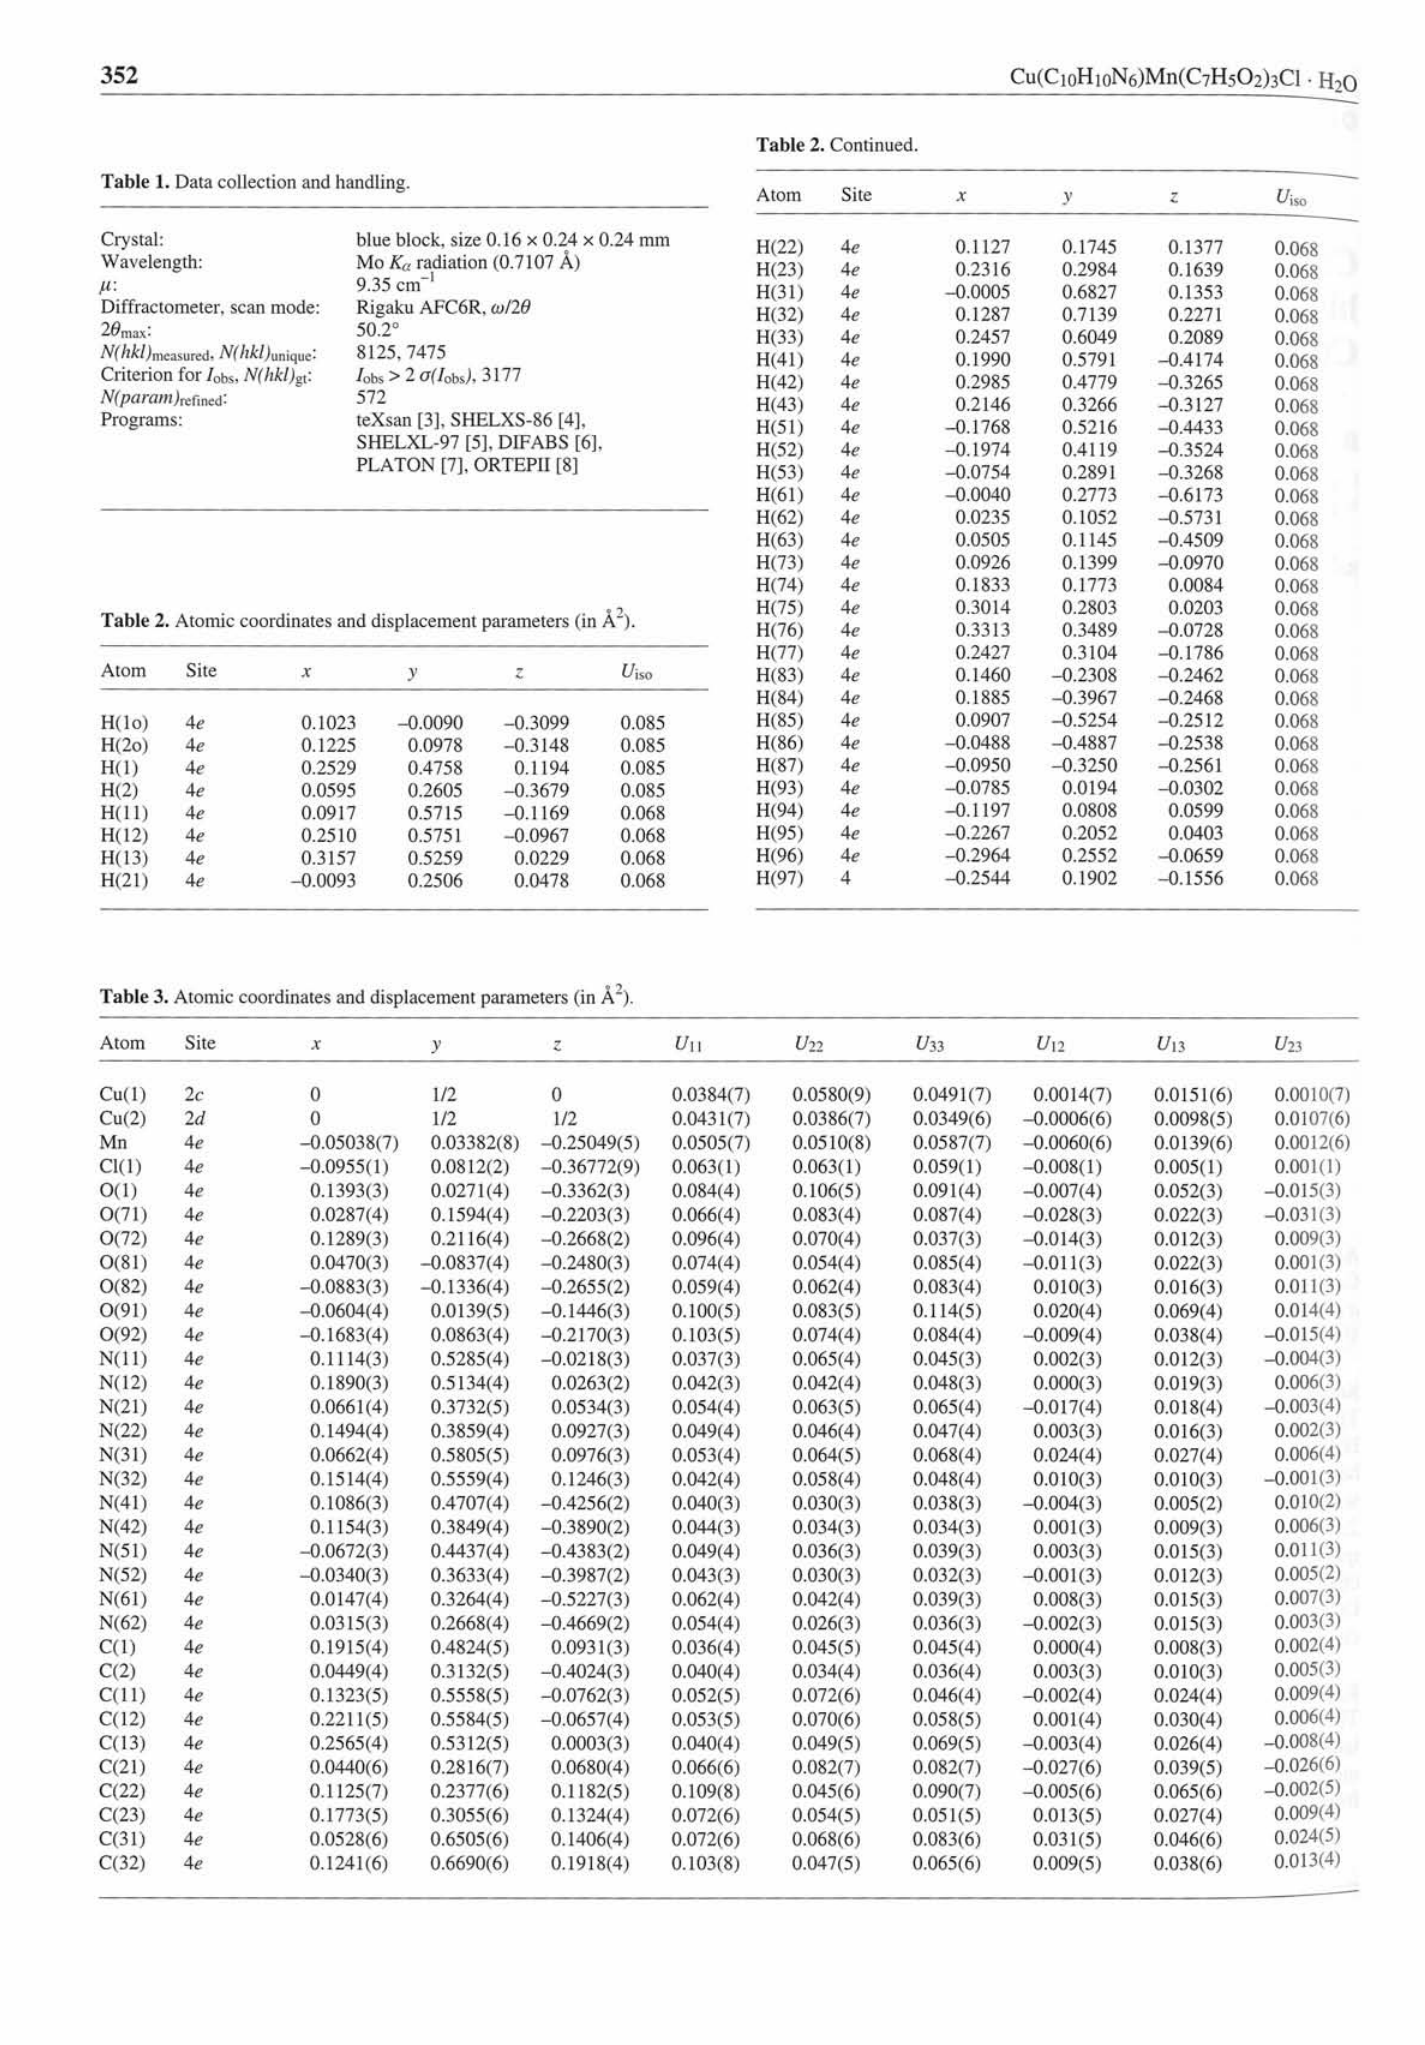
Table 1. Data collection and handling.